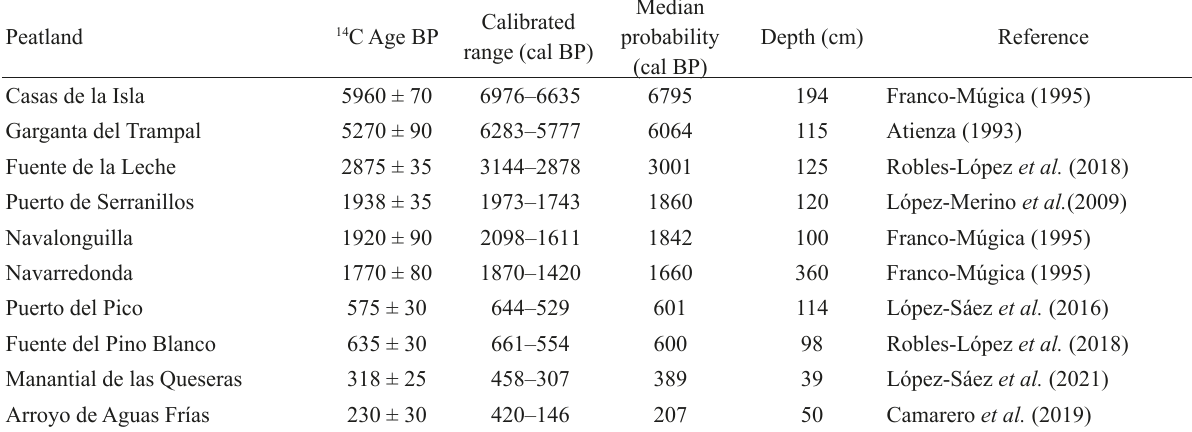
Table 12. Estimated date of peat inception in peatlands of the GRP. 14 C data (Age BP / Before Present) for the deepest peat (cm) level were calibrated (cal BP) using CALIB 8.2 software with the INTCAL20 curve. Calibrated radiocarbon dates are given as cal